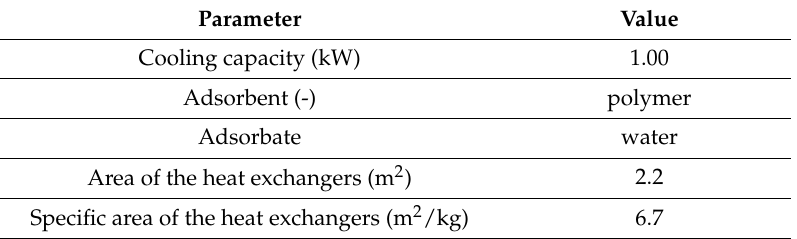
Table 6. Detailed parameters of the experimental prototype.